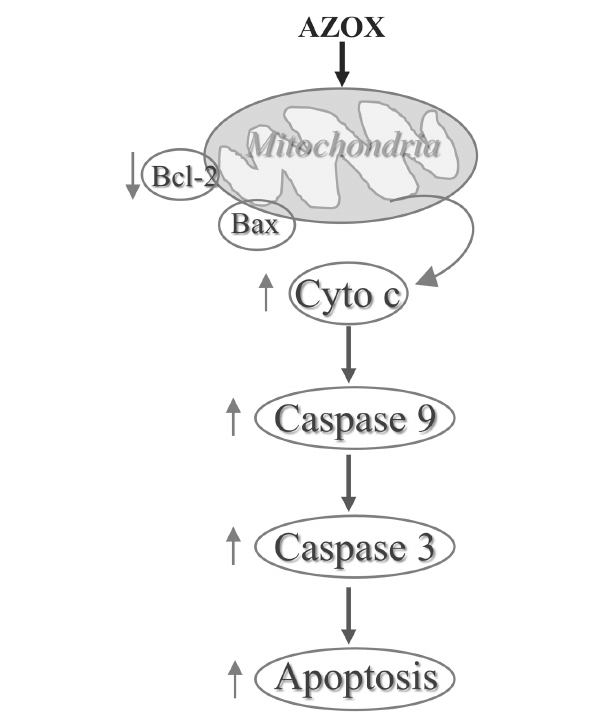
FIGURE 7 | AZOX induces KYSE-150 cell apoptosis via mitochondrial pathway by suppressing